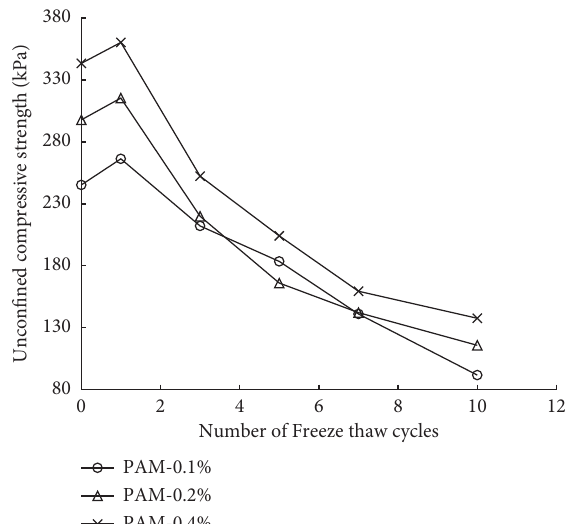
Figure 18: Changes of unconfined compressive strength of PAM (low content) stabilized specimens with freeze-thaw cycles.